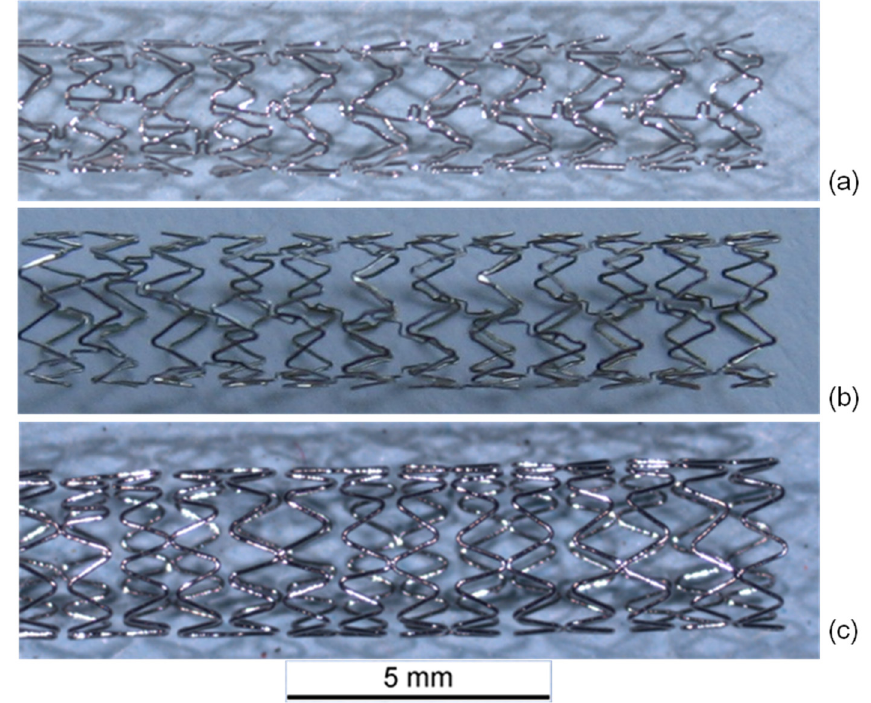
Figure 1. ( a ) Multi Link Vision (L-605, 81 μ m); ( b ) Coroflex ® Blue (L-605, 60 μ m); ( c ) Medtronic Driver (F-562, 91 μ